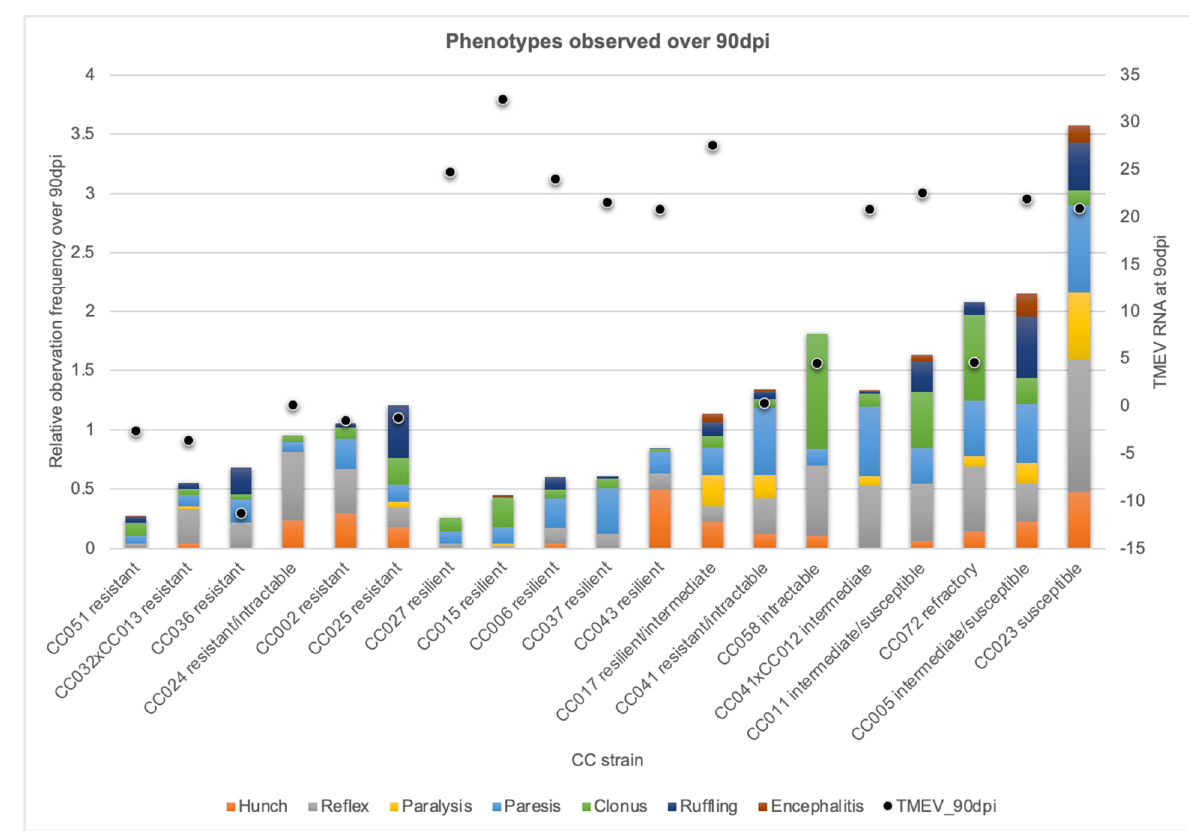
Figure 2. Full 90 dpi cumulative phenotype profiles for each strain are shown with each of the 7 phenotype categories distinguished by color. Strains are ordered from left to right by response category. “Relative observation frequency over 90 dpi” shows the cumulative frequencies of hunching, delayed righting reflex, paresis, paralysis, clonus, ruffling, and encephalitis observed over 90 dpi, as described previously [23]. “TMEV RNA at 90 dpi” shows levels of TMEV RNA measured at 90 dpi (log2FoldChange values) as dots.